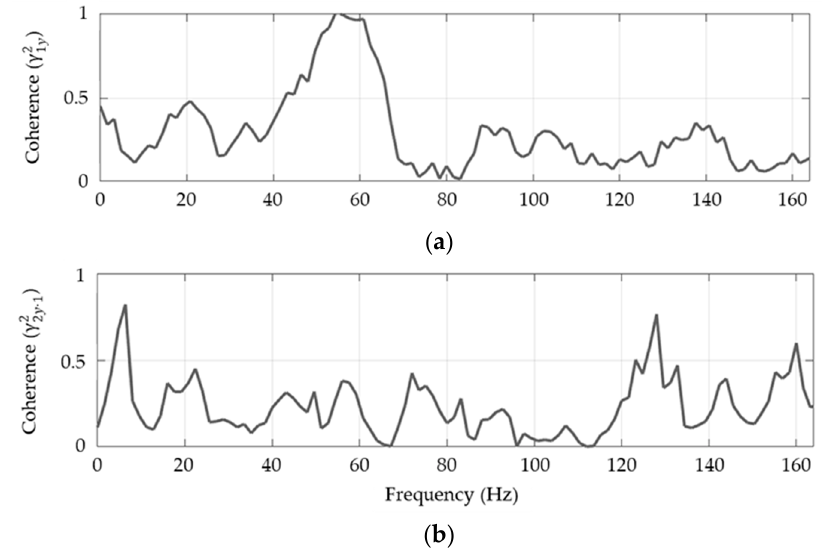
Figure 14. Partial coherence: ( a ) γ (cid:2869)(cid:3052)(cid:2870) , ( b ) γ (cid:2870)(cid:3052)∙(cid:2869)(cid:2870) .